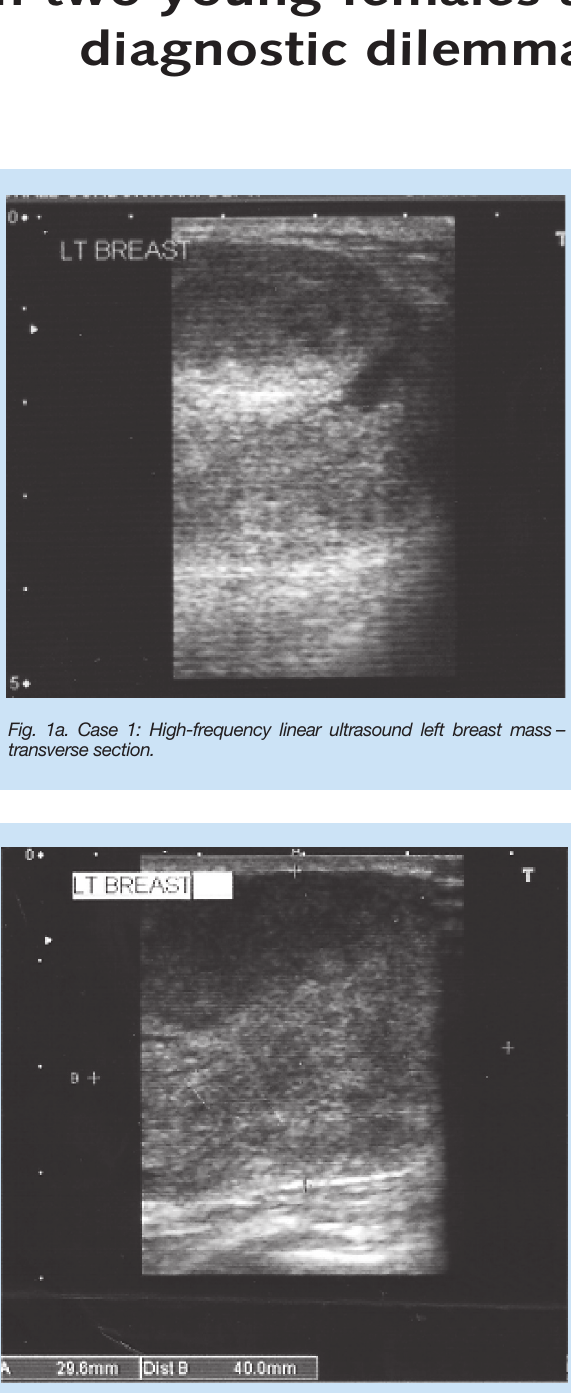
Fig. 1b. Case 1: High-frequency linear ultrasound of left breast mass – longitudinal